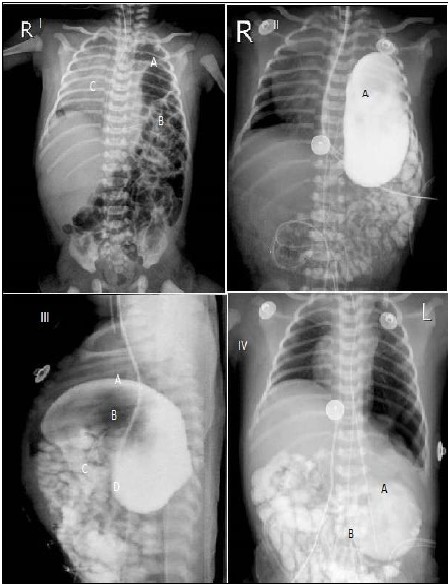
Figure 1: Plain CXR showing left sided congenital diaphragmatic eventration ( A) with herniation of stomach and small bowel loops (B) and mediastinal shift towards right side (C)(I). Upper GI Gastrograffin study shows the stomach and bowel loops located in the left lower chest (II-A) with greater curvature(A) noted above the lesser curvature(B) and pyloro-duodenal junction(C) noted above the gastro-esophageal junction(D) (III) with free flow of contrast from stomach. Skiagram on post-operative day 1(IV).